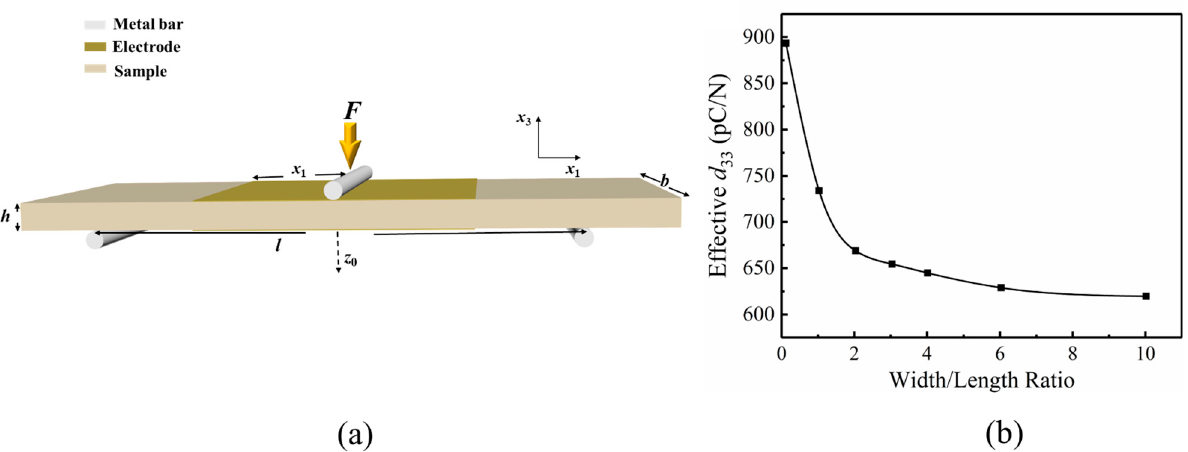
Figure 3. ( a ) Schematic of the three-point bending method used to apply a strain gradient. The three metal bars represent the three points. The dotted arrow represents the displacement of the center point when applying F . ( b ) The effect of the width-to-length ratio on the effective d 33 from the flexoelectric response for rectangular (Ba,Sr)TiO 3 ceramics. Reprinted with permission from [23]. Copyright 2010 World Scientific.